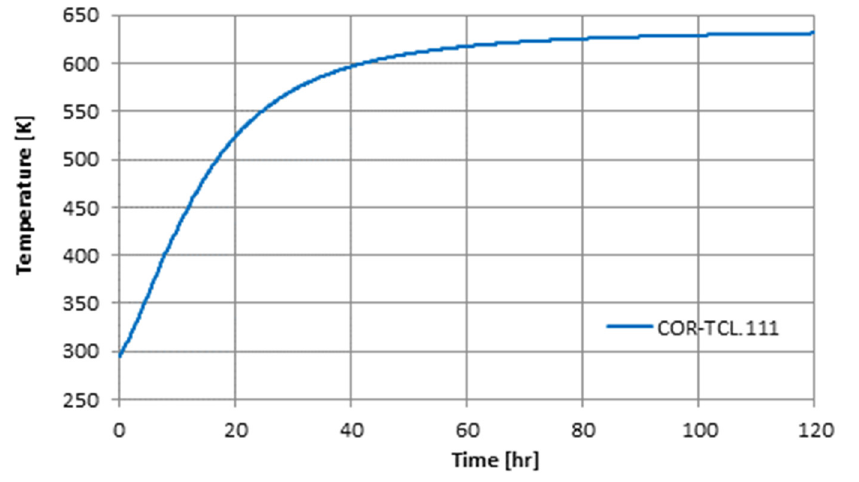
Figure 4. The MELCOR results—base case.